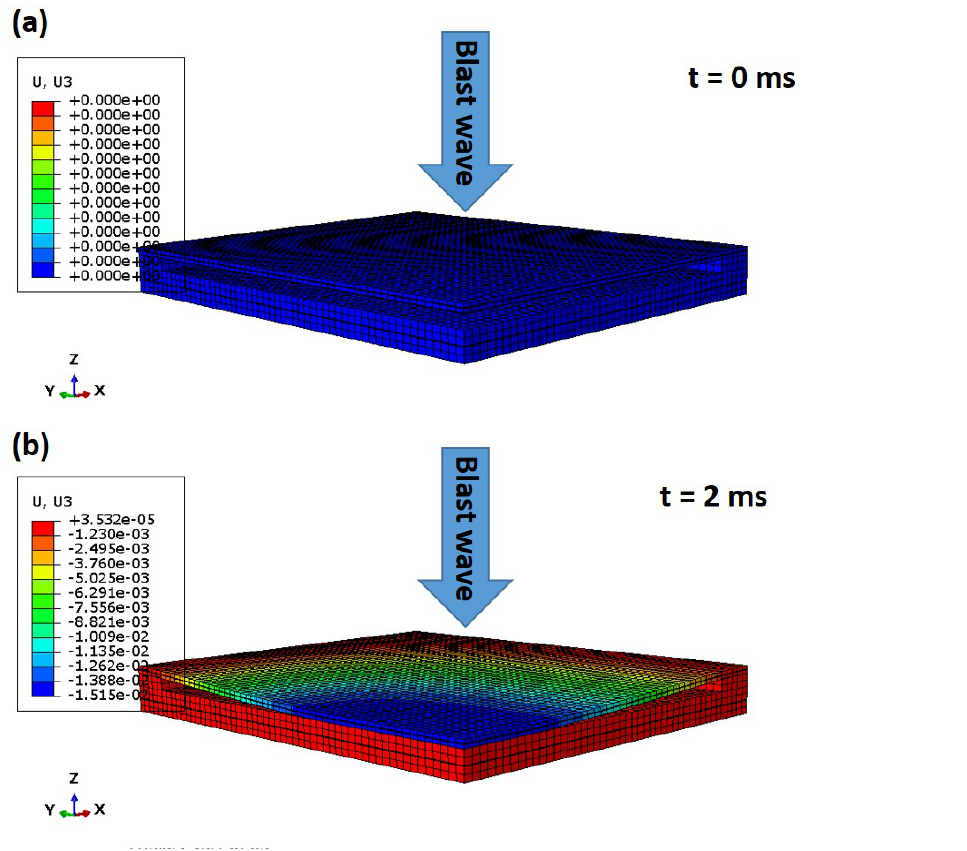
Fig. 3 : (a) Cut view of an ER3 blast loaded IGU 44.2/15/1515.2 at time t = 0 ms. (b) Cut view of an ER3 blast loaded IGU 44.2/15/1515.2 at time t = 2